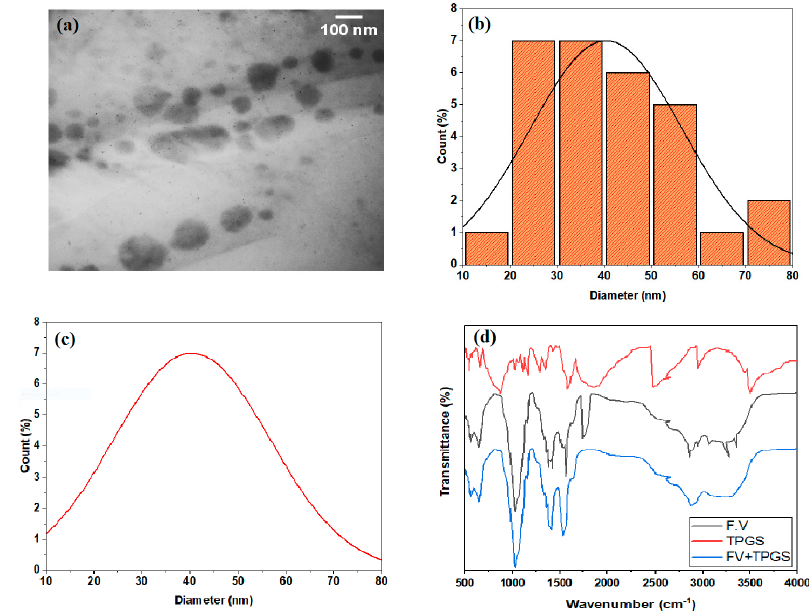
Scheme 1. Induction of sciatic nerve crush Figure 1. Characterization of nanosuspension of F. vulgare ( a ); TEM analysis ( b ); size distribution ( c ); FTIR analysis ( d ).